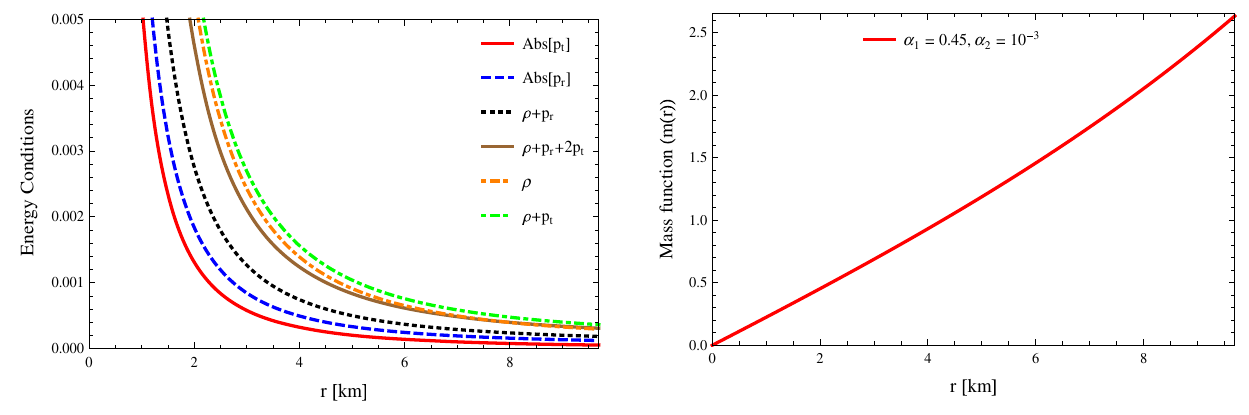
Fig. 7 Behaviour of the mass function when α 1 = 0 . 45, α 2 = 10 − 3 as functions of the radial coordinates r for spherical object PSR J1614- 2230